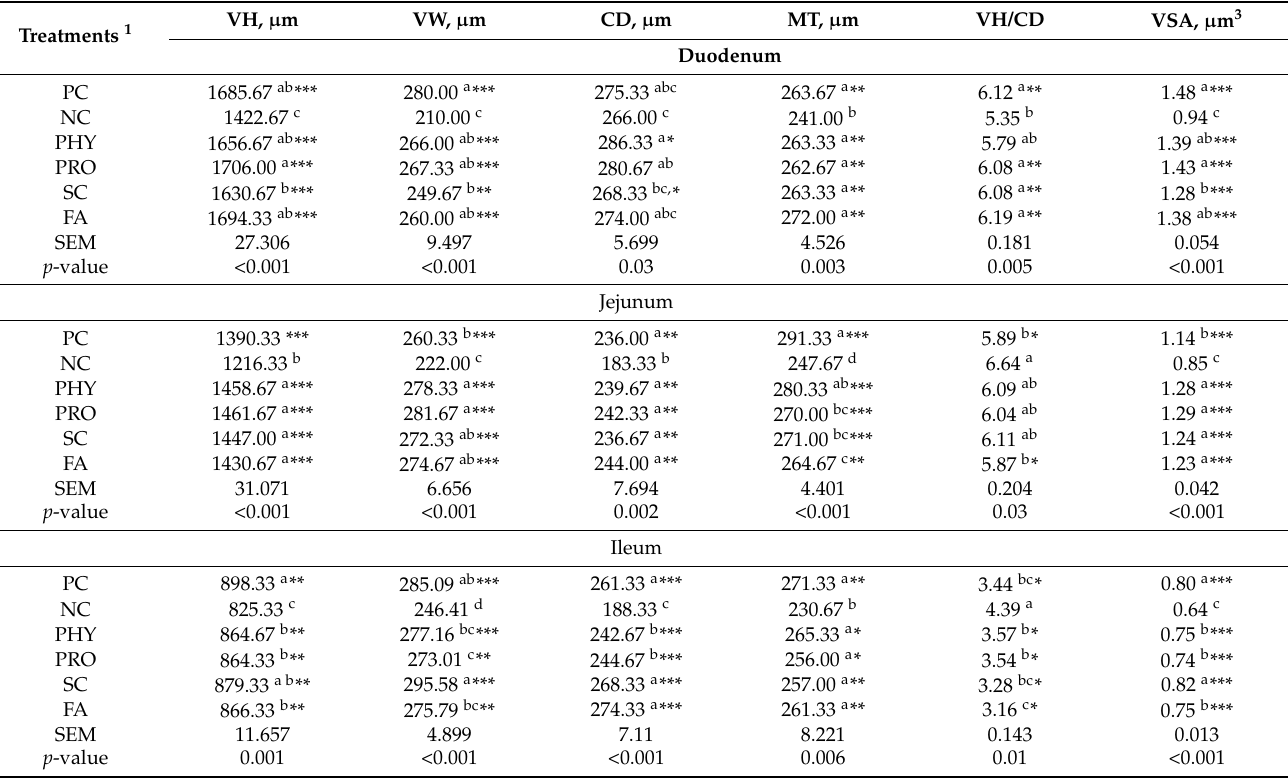
Table 9. Small intestine histomorphology of broiler chickens fed a reduced nPP diet